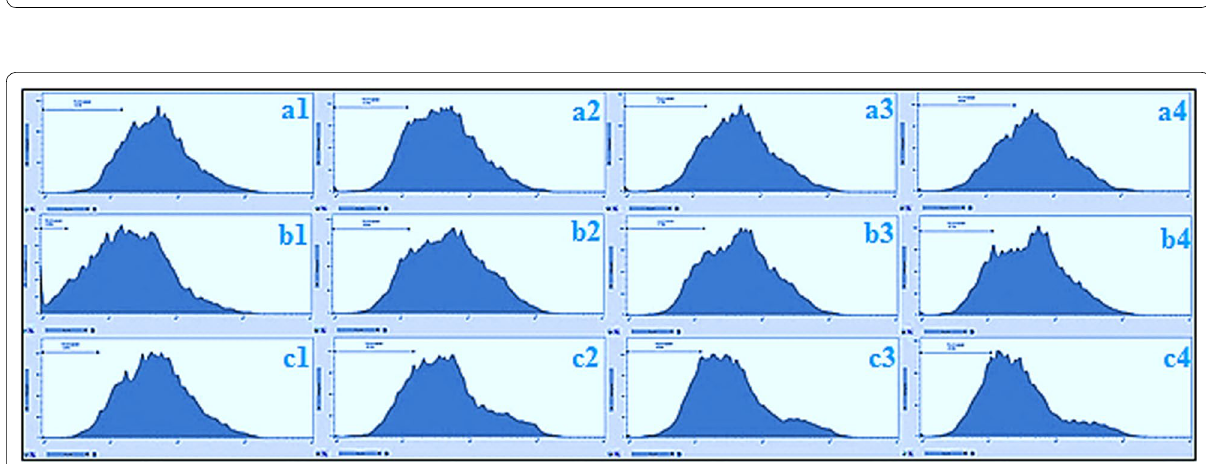
Fig. 5 Flow cytometric evaluation of induced apoptosis using Propidium iodide staining by L. usitatissimum extract extract in LNCaP cells at different times and concentration.a1-4 after 24 h a1: control a2-4 concentrations of 6.0, 8.3, 10.0 μg/mL; b1-4 after 48 h b1: control, b2-4concentratoions of 4, 6.3, 8.0 μg/mL; c1-4 after 72 h c1: control, c2-4: concentrations of 4, 5.4, 6